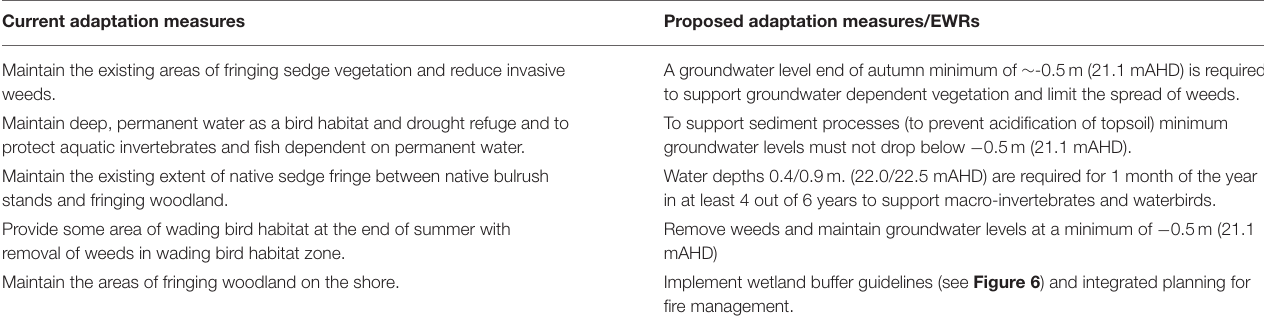
TABLE 2 | Ecological water requirements (EWRs) are the water depths and hydrological regimes necessary to maintain a low level of risk to the ecological values which is based on the state water requirements policy (EPA, 1992). Current adaptation measures Proposed adaptation measures/EWRs Maintain the existing areas of fringing sedge vegetation and reduce invasive